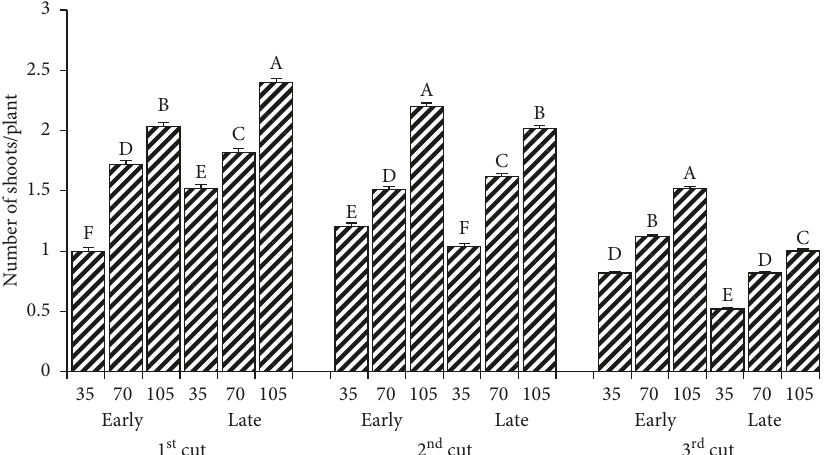
Figure 1: The number of shoots/plant of Sudan grass as affected by the interaction between cutting date and nitrogen fertilizer levels at the three cuts in the first season. The bars on the top of column represent the SE for each